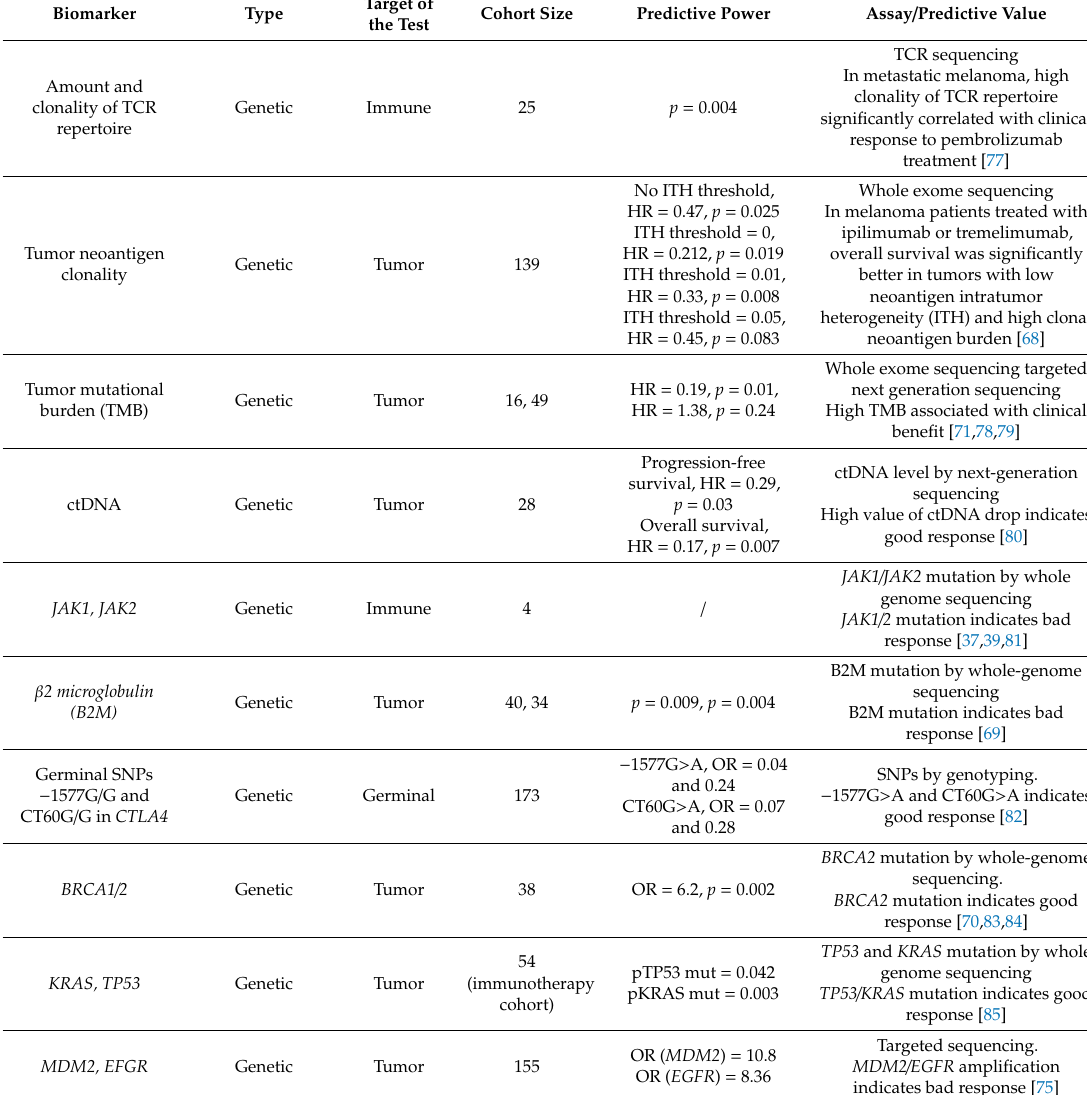
Table 3. Candidate response biomarkers for immune checkpoint